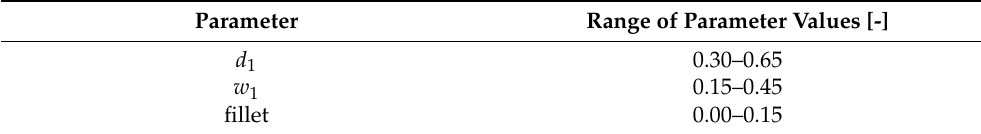
Table 2. Ranges of analyzed values of